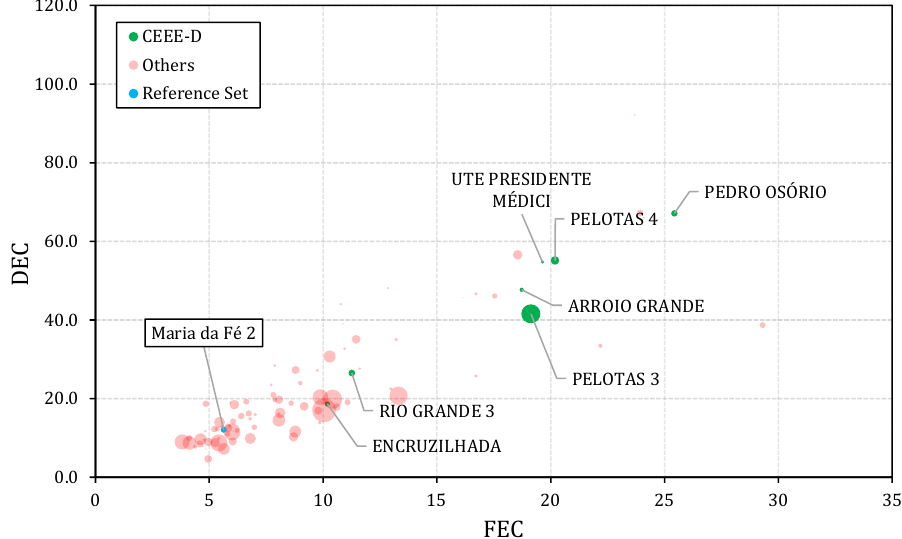
Figure 11. Impact of NUC_IND attribute on DEC and FEC performance for Pedro Osório cluster.